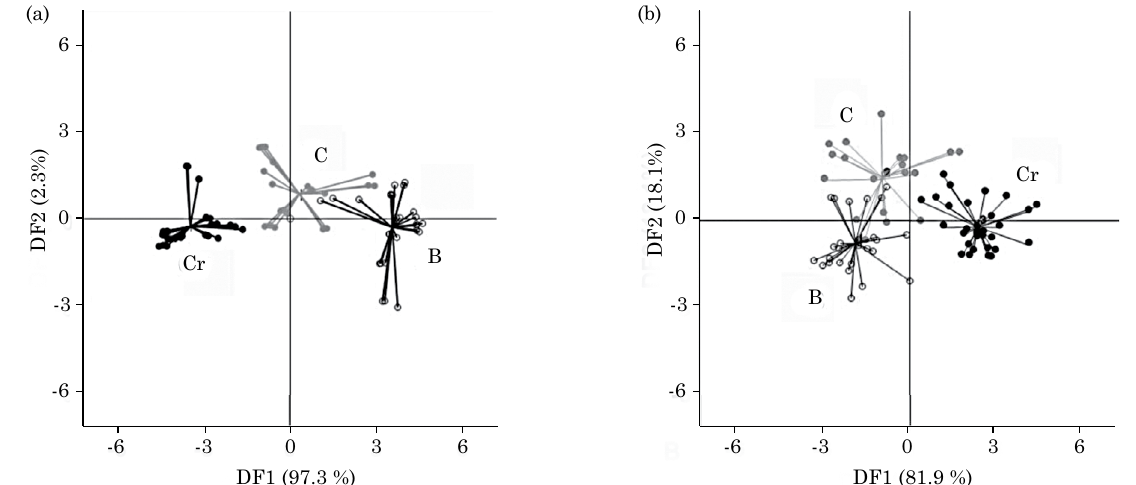
figure 2. Biplot for the fisher discriminant model for all the chemical (a) and physical (b) properties. within each frame: B and C: horizons, and Cr: saprolite